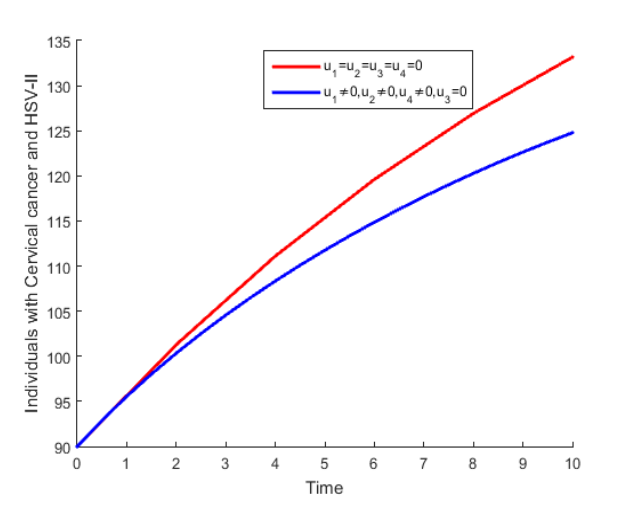
Fig. 3. Simulations showing optimal use of HPV prevention, HSV-II prevention and HSV-II treatment. Intervention IV. Optimal use of HPV prevention, HSV-II prevention and HPV treatment. This strategy shows effect of prevention effort for both HPV and HSV-II and treatment effort for HPV are used to optimize objective functional while setting treatment effort for HSV-II equal to zero. Results describe that, the number of infectious population decreases more rapidly with controls than the case without controls as illustrated in Fig. 4